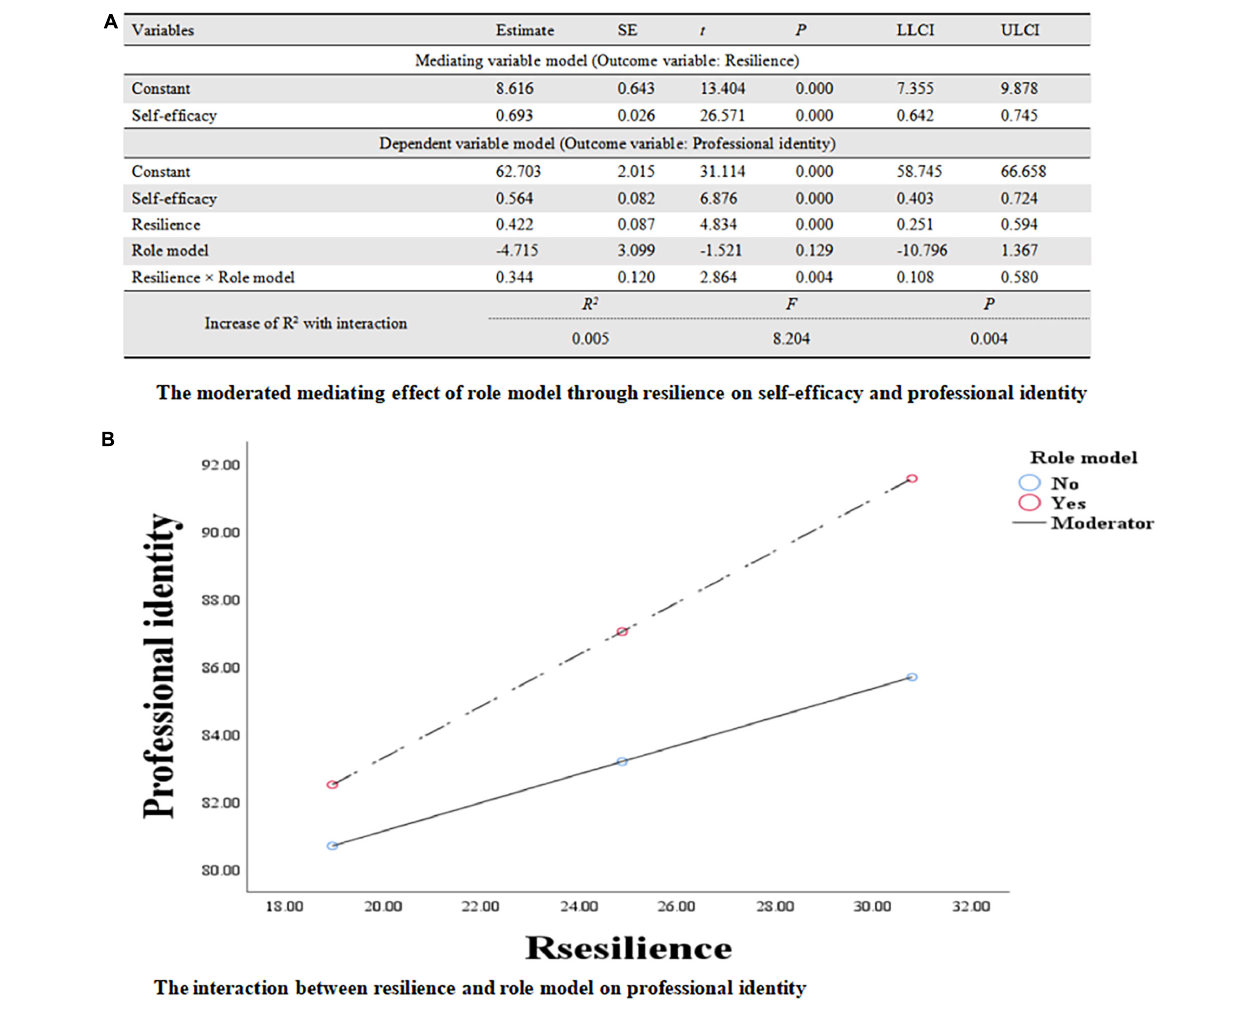
FIGURE 4 | (A) The moderated mediating effect of role model through resilience on self-efficacy and professional identity. (B) The interaction between resilience and role model on professional